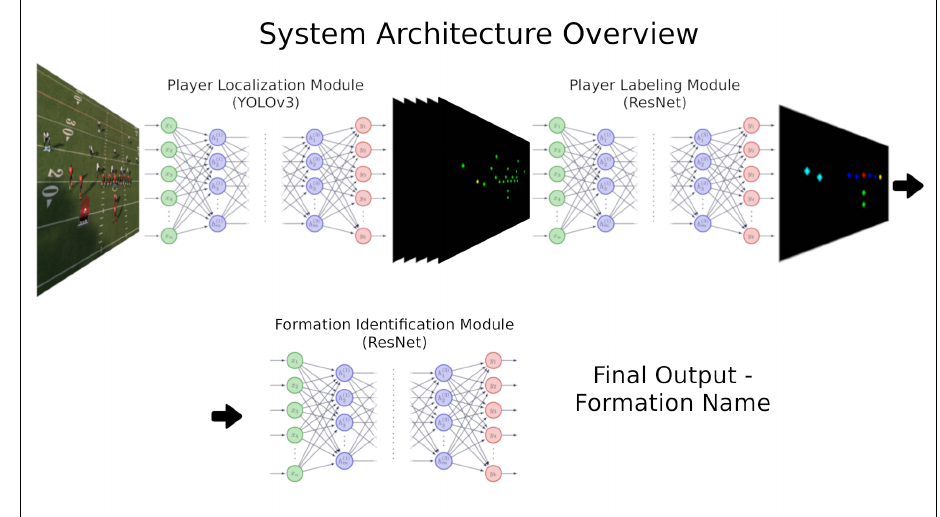
Figure 2. System architecture overview. the system consists of three modules: (1) player localization, (2) player labeling, and (3) formation